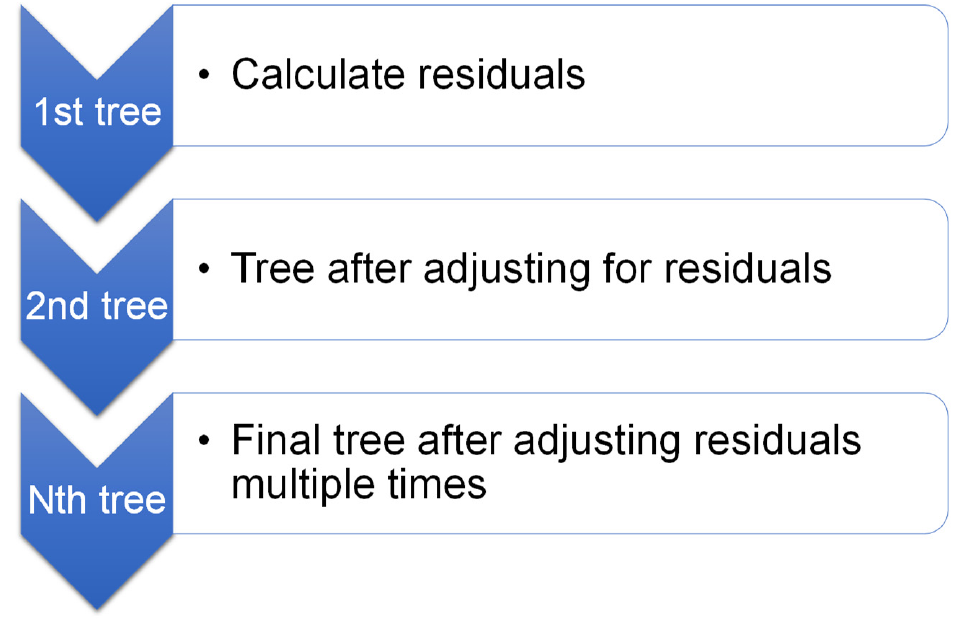
Figure 4. Schematic representation of the gradient boosting technique.